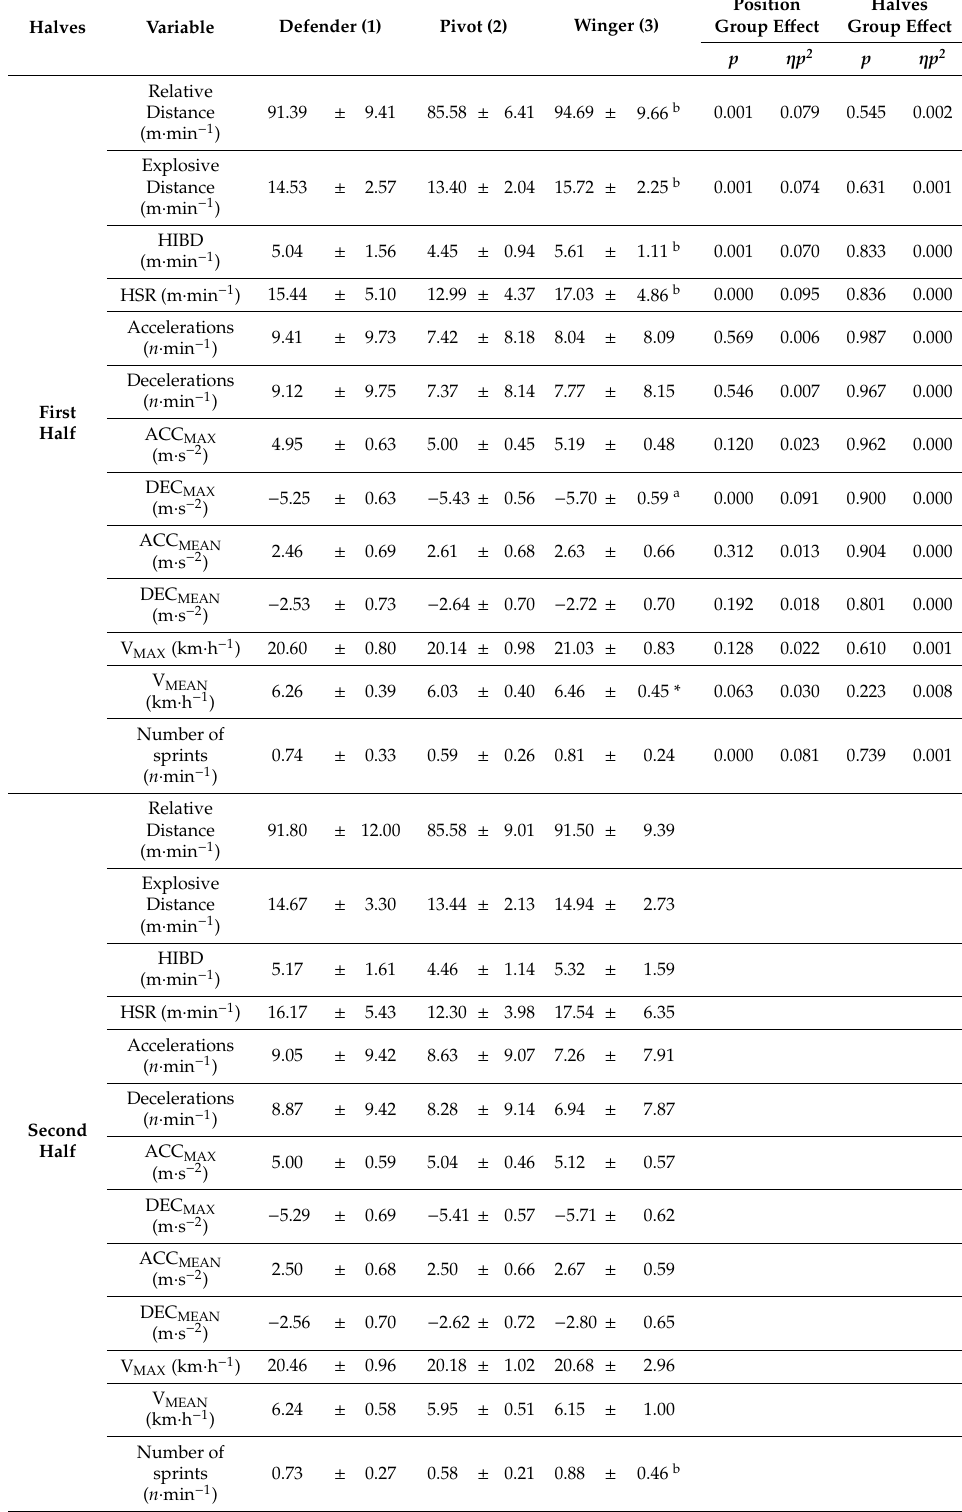
Table 1. Physical actions during the first and second half of the futsal match according to the playing